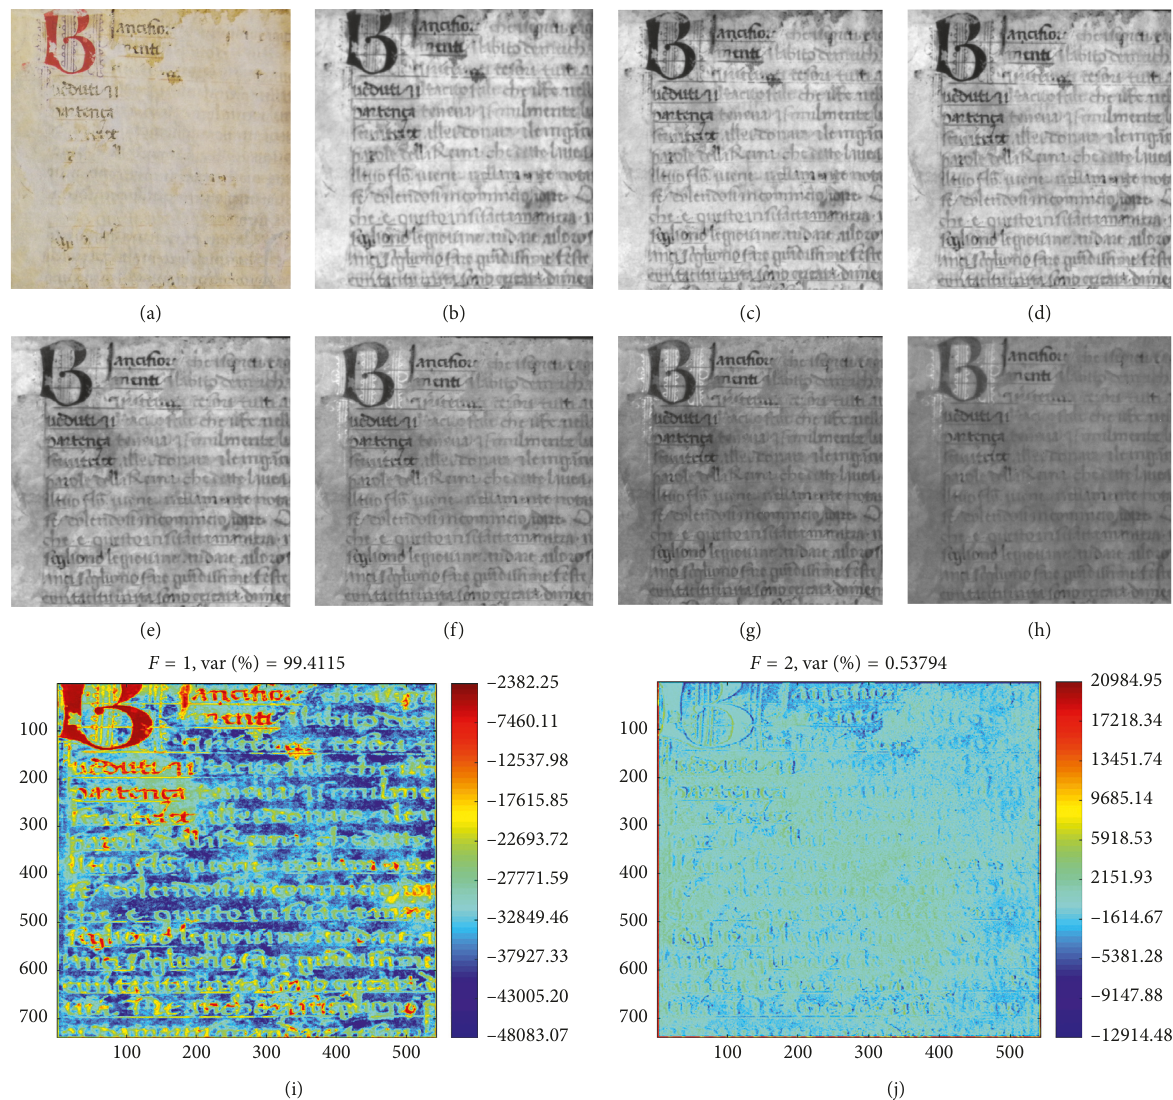
Figure 10: Photography (a) and UV fluorescence images taken at 470nm (b), 500nm (c), 532nm (d), 600nm (e), 680 nm (f), 700nm (g), and 750nm (h) of a detail of Parch. 38. (i, j) Image processing results by PCA: score image of PC1 (variance 99.41%) and score image of PC2 (variance